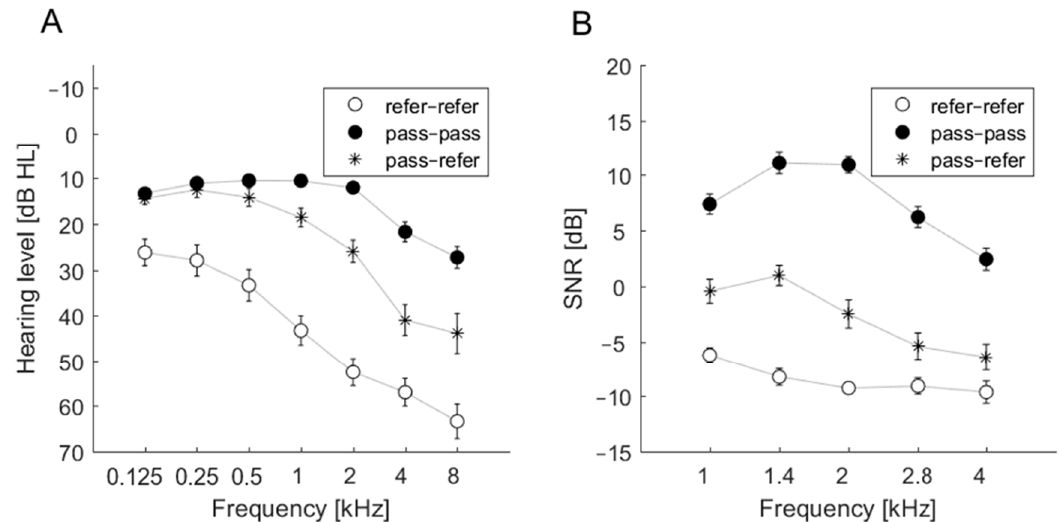
Figure 1. Average pure tone audiometry (PTA) thresholds ( A ) and average signal-to-noise ratio (SNR) ( B ) of transiently evoked otoacoustic emissions (TEOAEs) as measured by the ILO device for three groups: refer–refer, pass–pass, and pass–refer.